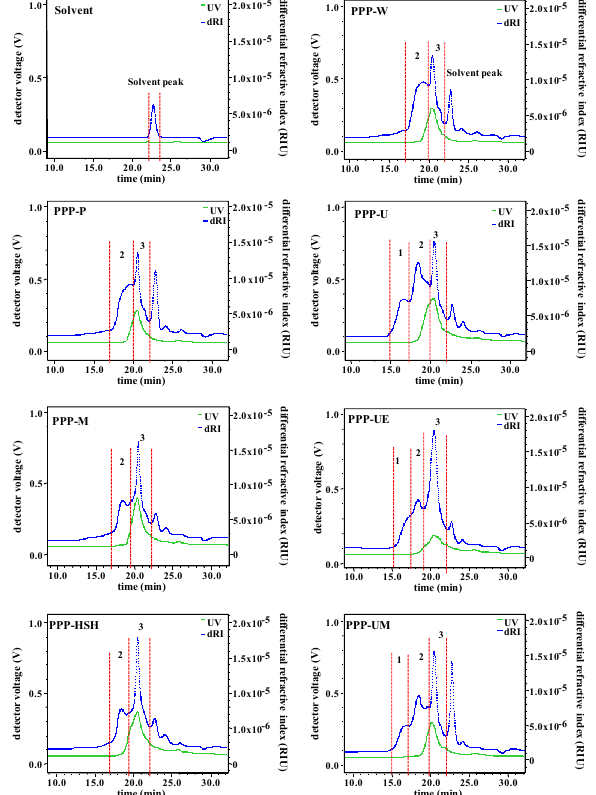
Figure 1. High performance size exclusion chromatograms of PPPs. The codes of samples were the same as in Table 1.